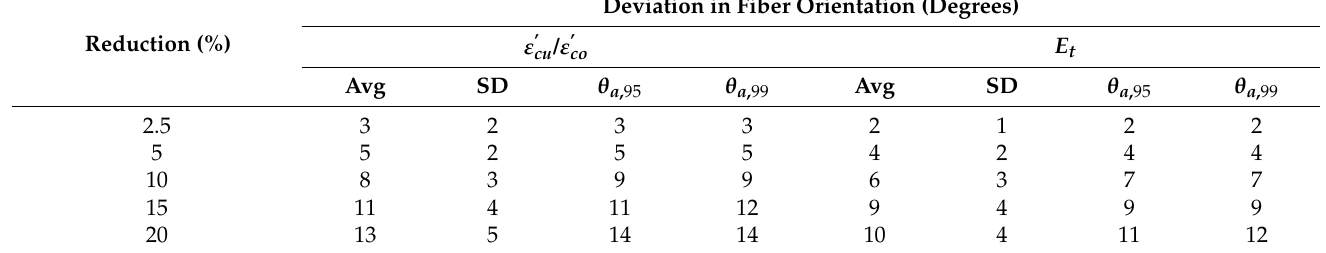
Table 13. Fiber orientations for different reductions in ε (cid:48) cu / ε (cid:48) co and E t .